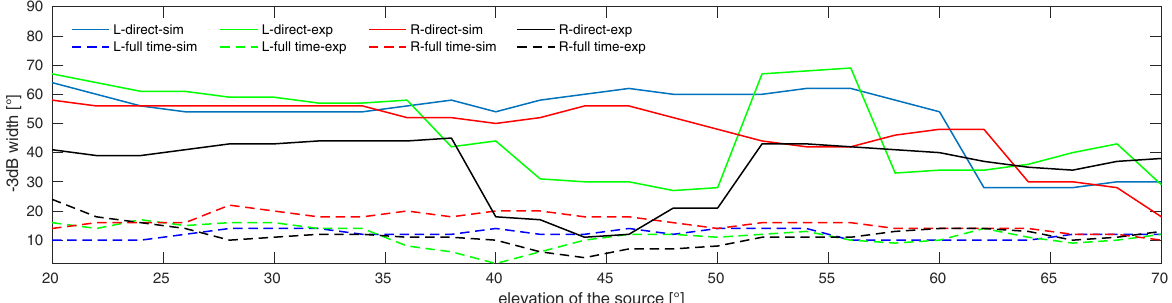
Figure 12. (cid:2) 3dB width of the focusing functions for the direct and full-time correlations and left (L) and right (R) receivers when the input signal is a linear chirp as in Figure 11 for simulations and a narrower-band linear chirp for experimental